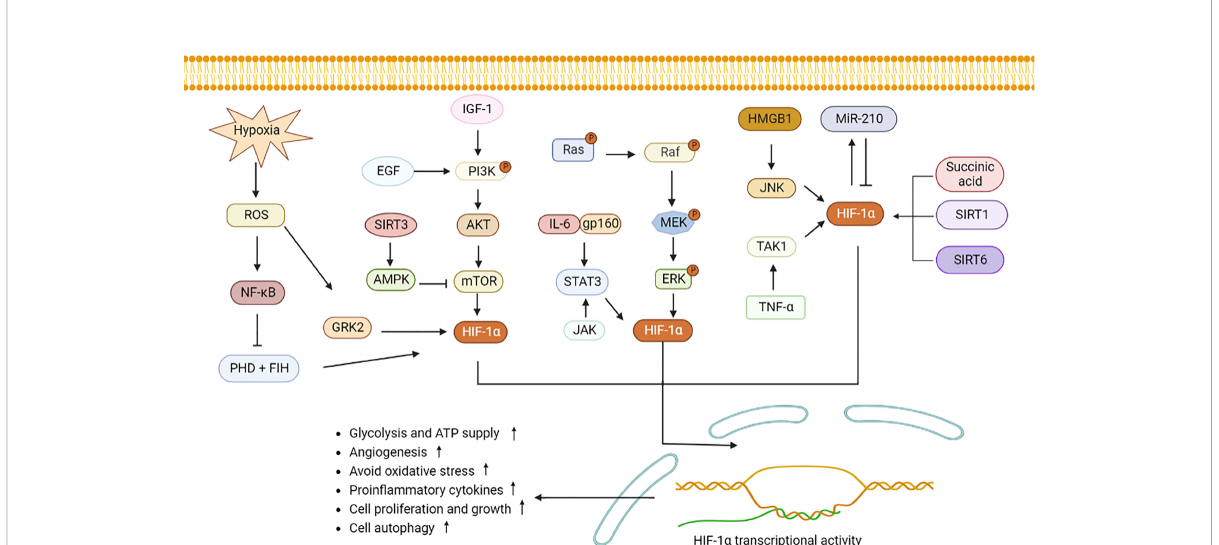
FIGURE 1 HIF-1 a signaling pathway induces in fl ammatory response and metabolic changes. Hypoxia induces GRK2 and NF- k B expression by stimulating ROS and increases HIF-1 a expression. PHD and FIH can be inhabited by NF- k B, leading to accumulation of HIF-1 a . PI3K stimulated by EGF and IGF-1 induces Akt and mTOR to elevate HIF-1 a secretion. SIRT3 activates AMPK to decrease mTOR expression. IL-6 binds to gp160, JAK, and ERK, and then stimulates STAT3/HIF-1 a signaling. Similarly, succinic acid, SIRT1 and SIRT6 increase the intracellular expression of HIF-1 a . MiR- 210 interacts with HIF-1 a . High level of HIF-1 a promotes angiogenesis, cell migration and invasion, increases pro-in fl ammatory cells differentiation and cytokines production. ROS, reactive oxygen species; GRK2, G protein-coupled receptor kinase 2; PHD, proline hydroxylase; FIH, HIF asparaginyl hydroxylase; STAT3, signal transducer and activator of transcription 3; PI3K, phosphatidylinositol-3-kinase; Akt, protein kinase B; mTOR, mammalian target of rapamycin; IL-6, interleukin-6; NF- k B, nuclear factor- k B; JAK, Janus kinase; MAPK, mitogen-activated protein kinases; ERK, regulated extracellular protein kinases; HMGB1, high mobility group protein 1; JNK, c-Jun N-terminal kinase; TNF- ɑ , tumor necrosis factor-alpha; TAK1, transforming growth factor-activated kinase 1; miR-210, microRNA-210; AMPK, adenosine monophosphate activated protein kinase; SIRT1, sirtuin